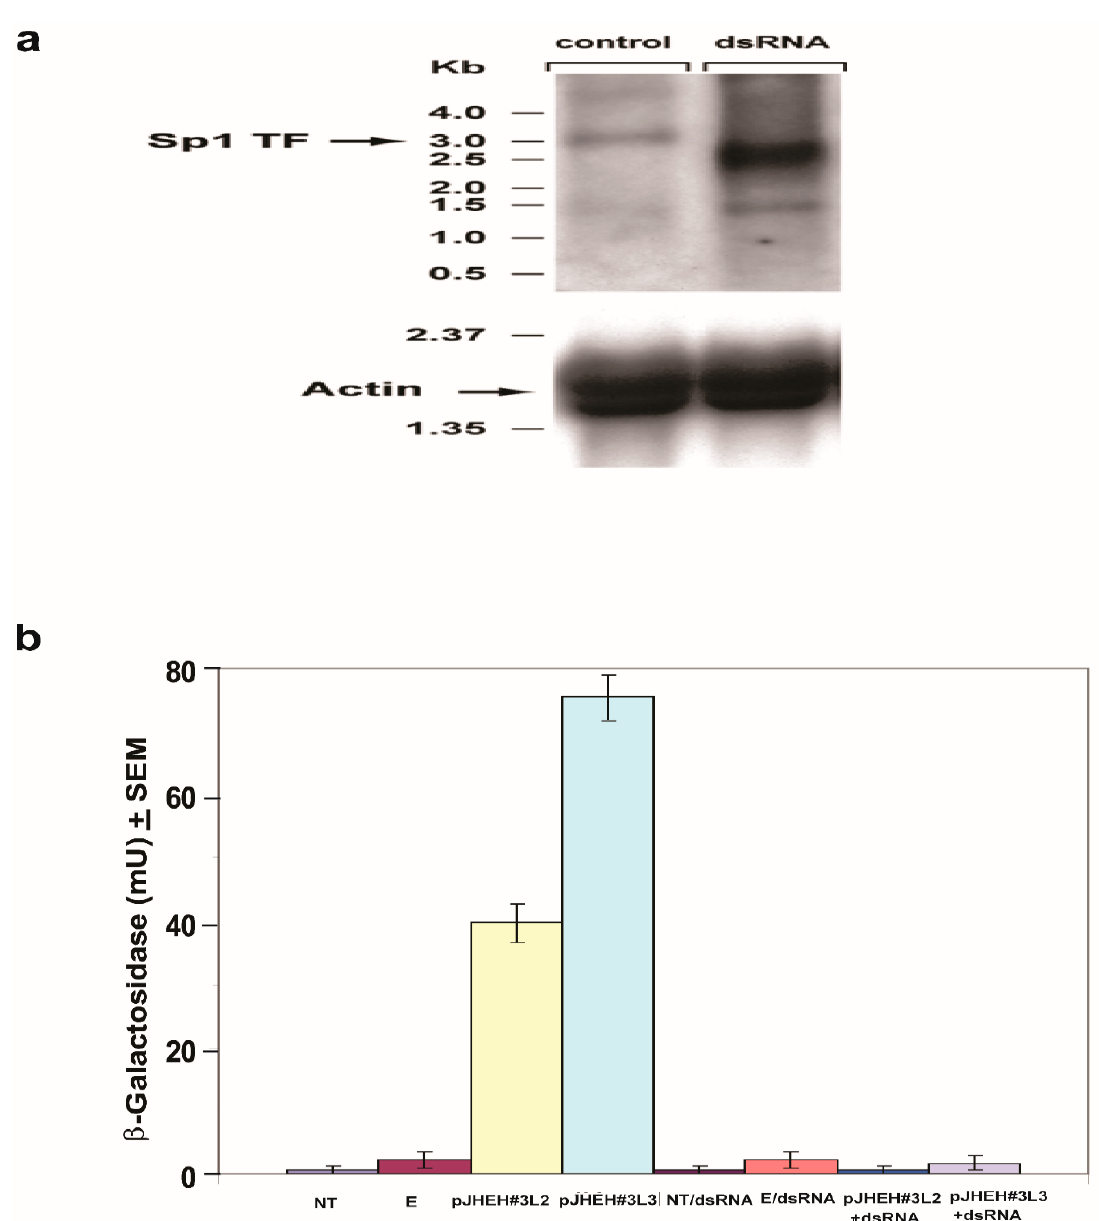
Figure 9. Northern blot analysis of TF Sp1 in D.Mel2 cells that were transfected with promoter pJHEH#3L3 and treated with dsRNA against Sp1. ( a ) In cells that were treated with dsRNA, the Sp1 transcript is degraded (right lane) compared with untreated cells (left lane). ( b ) Transcriptional activity of pJHEH#3L2 and pJHEH#3L3, in transfected D.Mel2 cells is not affected, whereas the activity in cells that were treated with dsRNA is similar to cells that were not transfected (NT) or cells that were transfected with an empty plasmid ©.